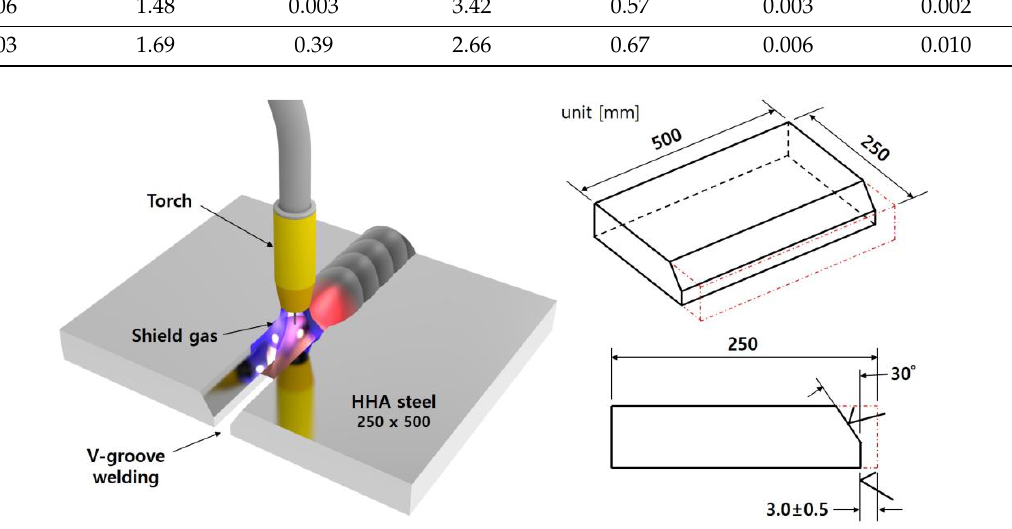
Figure 1. Specimen dimensions.